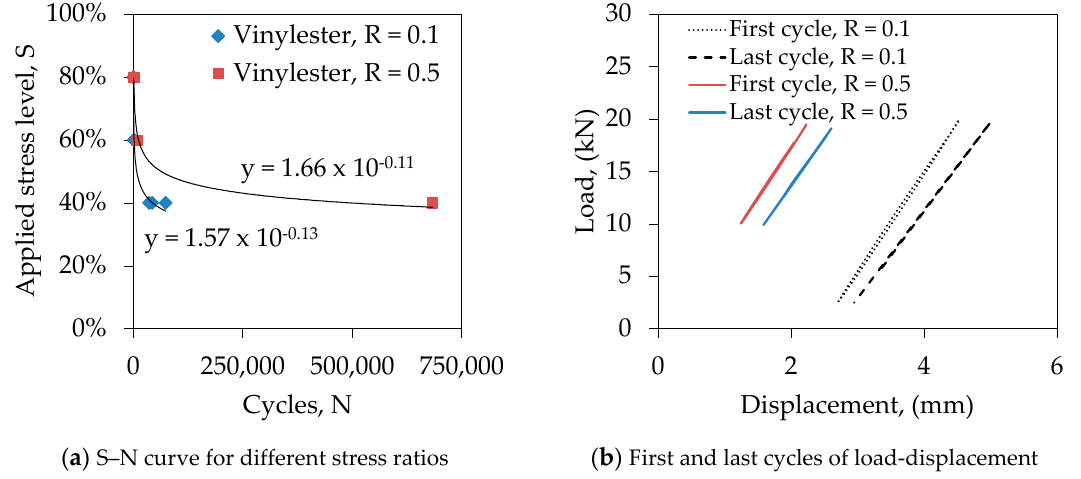
Figure 5. Comparison between different stress ratios.